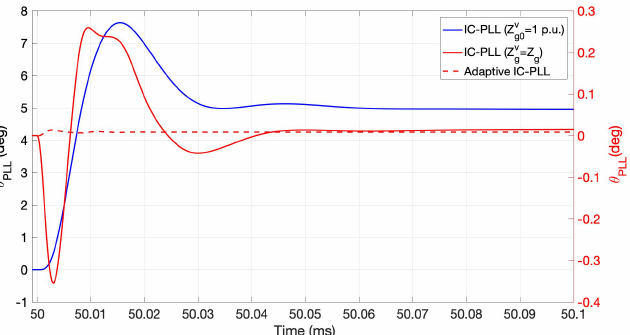
Figure 10. Time-domain response of the θ PLL for different types of PLLs for step change in Z g = 1 1.1 p.u. and for ω FL , PLL = 400 rad/s (inverter